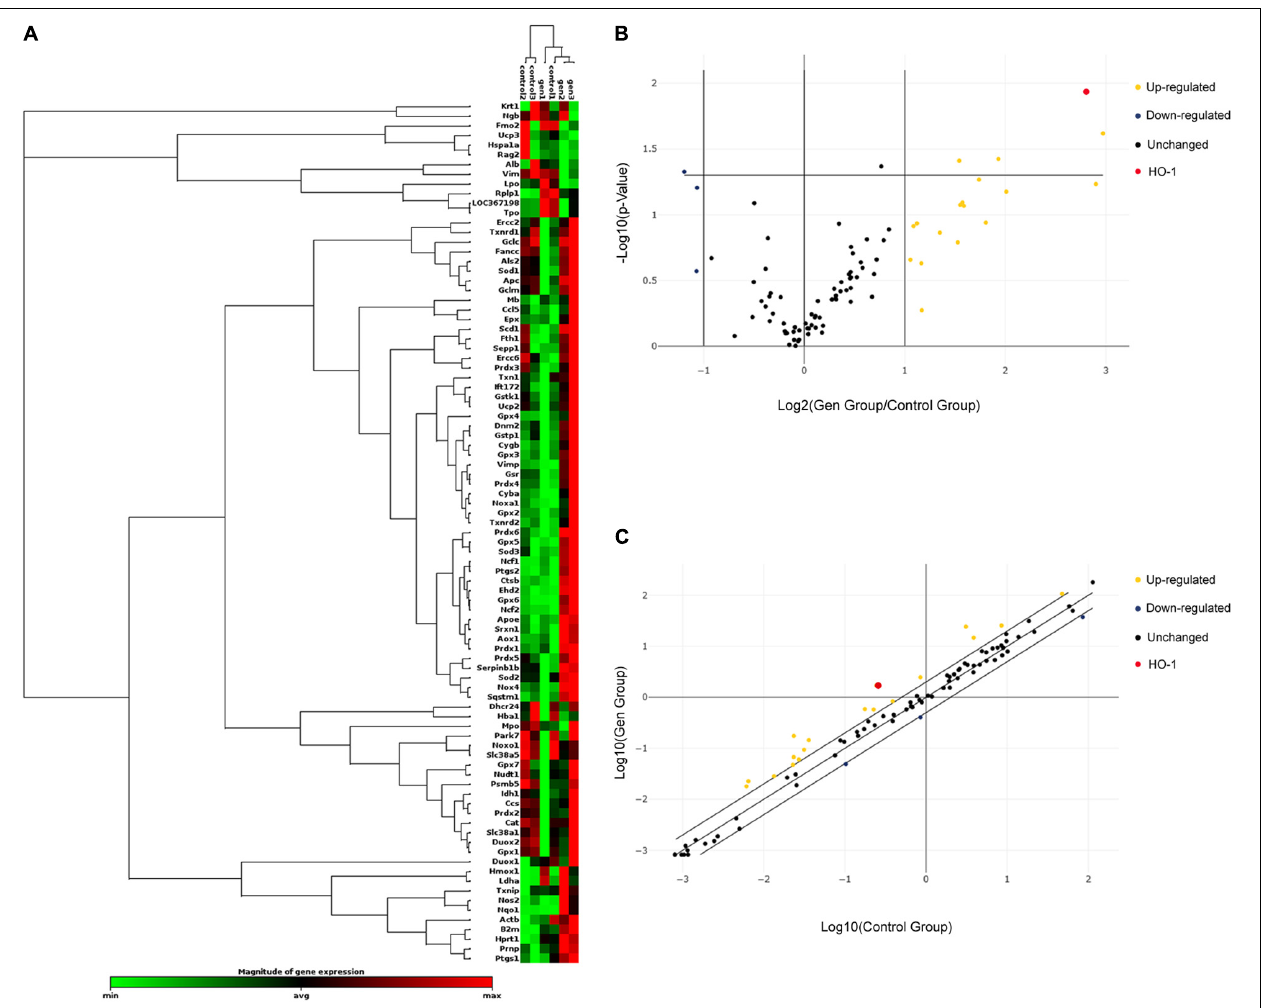
FIGURE 1 | Relative expression of 84 oxidative stress-related genes in the control and gentamicin (0.6 mM) groups. (A) Hierarchical clustering of the 84 detected genes involved in oxidative stress in the cochlea, with expression levels ranging from low (green) to high (red). (B) The volcano plot shows notable gene expression changes between the control and gentamicin groups by plotting the log2 fold change in mRNA amounts on the x-axis and their statistical significance on the y-axis. (C) The scatter plot illustrates log-transformed relative expression levels for various genes (2 − (cid:49) Ct ) between the control group (x-axis) and the gentamicin group